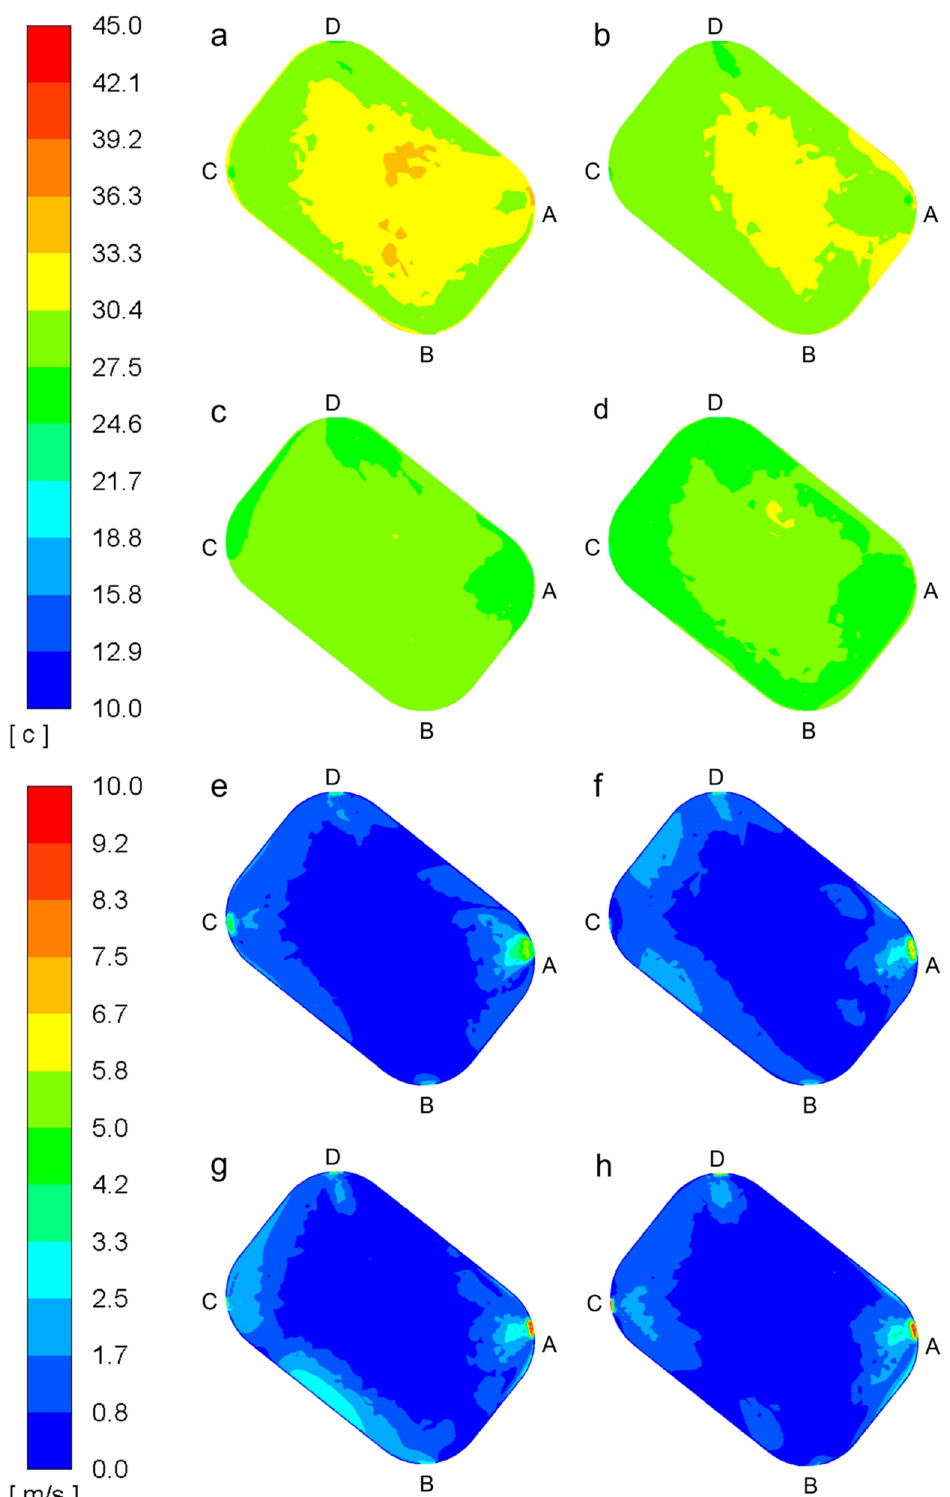
Figure 11. ( a – d ) Temperature contours of the pitch for scenarios one to four. ( e – h ) Wind velocity contours of the pitch for scenarios one to four.